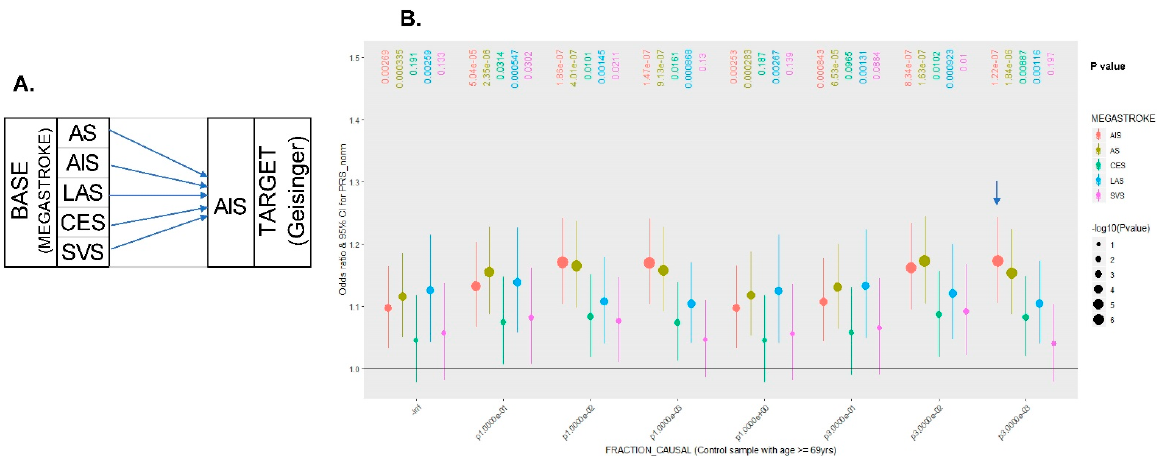
Figure 2. LDpred (nonuniform shrunk) to determine which fraction of causal variants provides the best prediction of the phenotype (ischemic stroke). ( A ) Layout of the PRS construction BASE files collected from the MEGASTROKE consortium used to estimate the effect size for each variant; the TARGET file is referred to as the genotyping file from the Geisinger Stroke Registry (GNSIS). ( B ) PRS calculated by LDpred based on the non-infinitesimal distribution (Gaussian mixture prior) of effect sizes compared to that based on infinitesimal distribution of effect sizes. PRS was normalized and, a logistic regression adjusted according to the covariates, including sex, PC 1–5 was performed to determine the association with IS. Because the causal variant fraction ( ρ ) is unknown for any given disease, a range of ρ values (i.e., 1, 0.3, 0.1, 0.03, 0.01, 0.003, and 0.001) was used. This process helped to determine which fraction of causal variants provided the best prediction of phenotypes. The seven candidate LDpred scores vary with respect to the tuning parameter ( ρ ) which is the proportion of variants assumed to be causal. The PRS generated from MEGASTROKE AS and AIS predicted Geisinger achieved better IS prediction results with larger ORs (i.e., a fraction of causal variants at 0.003 resulted in the largest ORs using AIS summary statistics, as indicated by the arrow) than the PRS generated from MEGASTROKE subtypes, such as LAS, SVS, and CES. Overall, these LDpred scores based on the non-infinitesimal distribution of effect sizes were larger than those obtained using infinitesimal